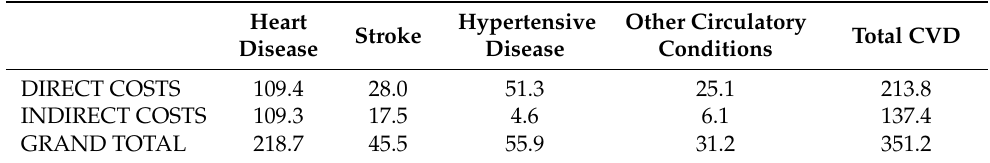
Figure 1. CVD vs cancer deaths (year 2016) and projected total costs of CVD (years 2015–2035) in the USA (illustration content elaborated and modified form the original work by Benjamin et al., 2020 [5]). Table 1. Estimated direct and indirect costs (in billions, $) of CVD in the USA 2014–2015 (table content elaborated and modified from the original work by Benjamin et al., 2020 [5])